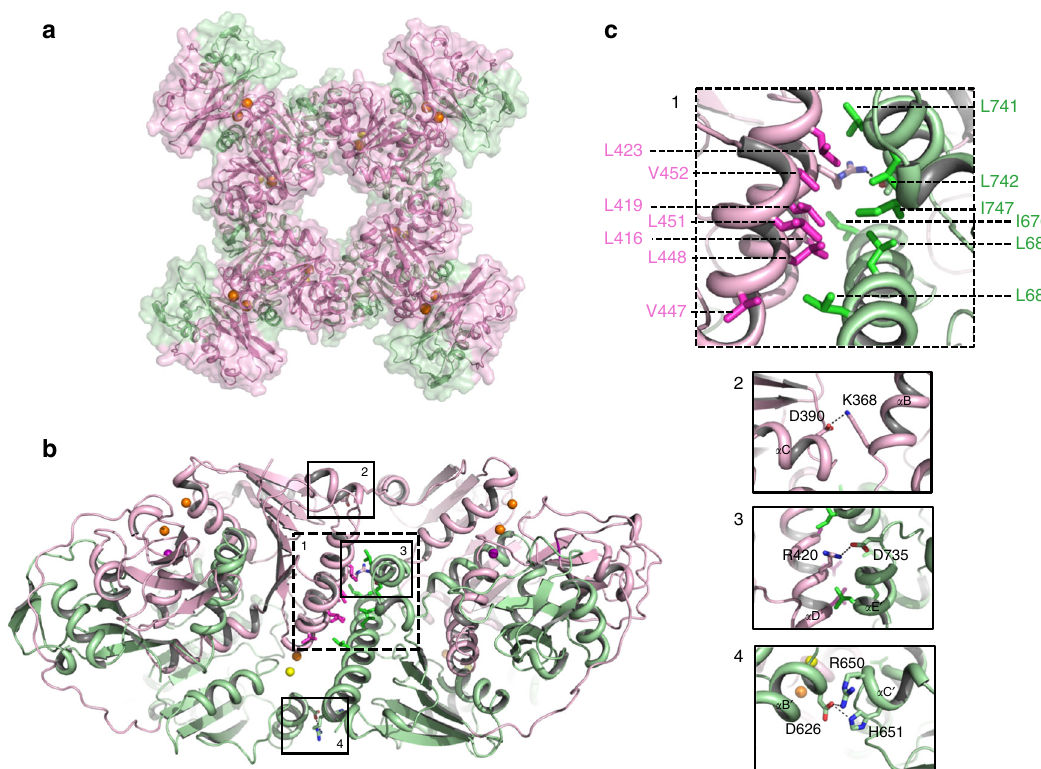
Fig. 3 Structure of the Ca 2 + -bound LjCASTOR gating ring composed of four subunits. a Top view of the crystal structure of the LjCASTOR gating ring with the same color representation as in Fig. 2a. b Side view of LjCASTOR gating ring and inter-subunit interactions. c Zoomed-in views of the boxed regions in b . The dashed box (c1) highlights the residues in the assembly interface involved in the network of hydrophobic interactions between α D and α E in RCK1 and α D ʹ and α E ʹ in RCK2 from the neighboring subunit. The main salt bridges on the inter-subunit interface are illustrated in the solid boxes (c2 –